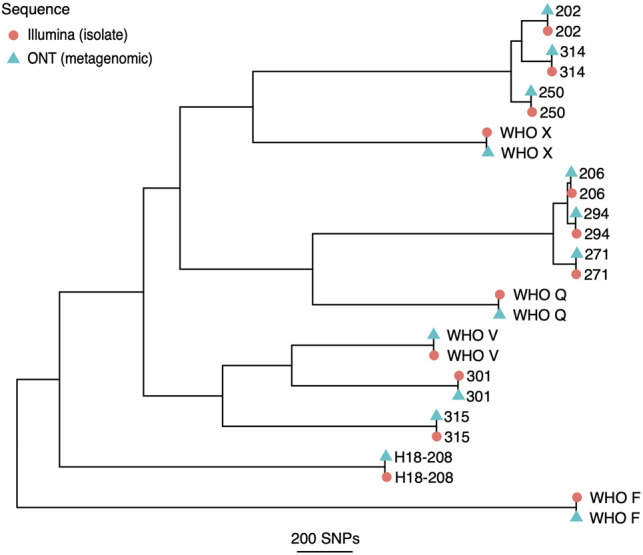
Recombination-corrected maximum likelihood tree of metagenomic Nanopore and paired Illumina isolate sequences. All Nanopore consensus sequences were generated from metagenomic sequencing with the exception of H18-208 and WHO Q, which were sequenced from isolates.